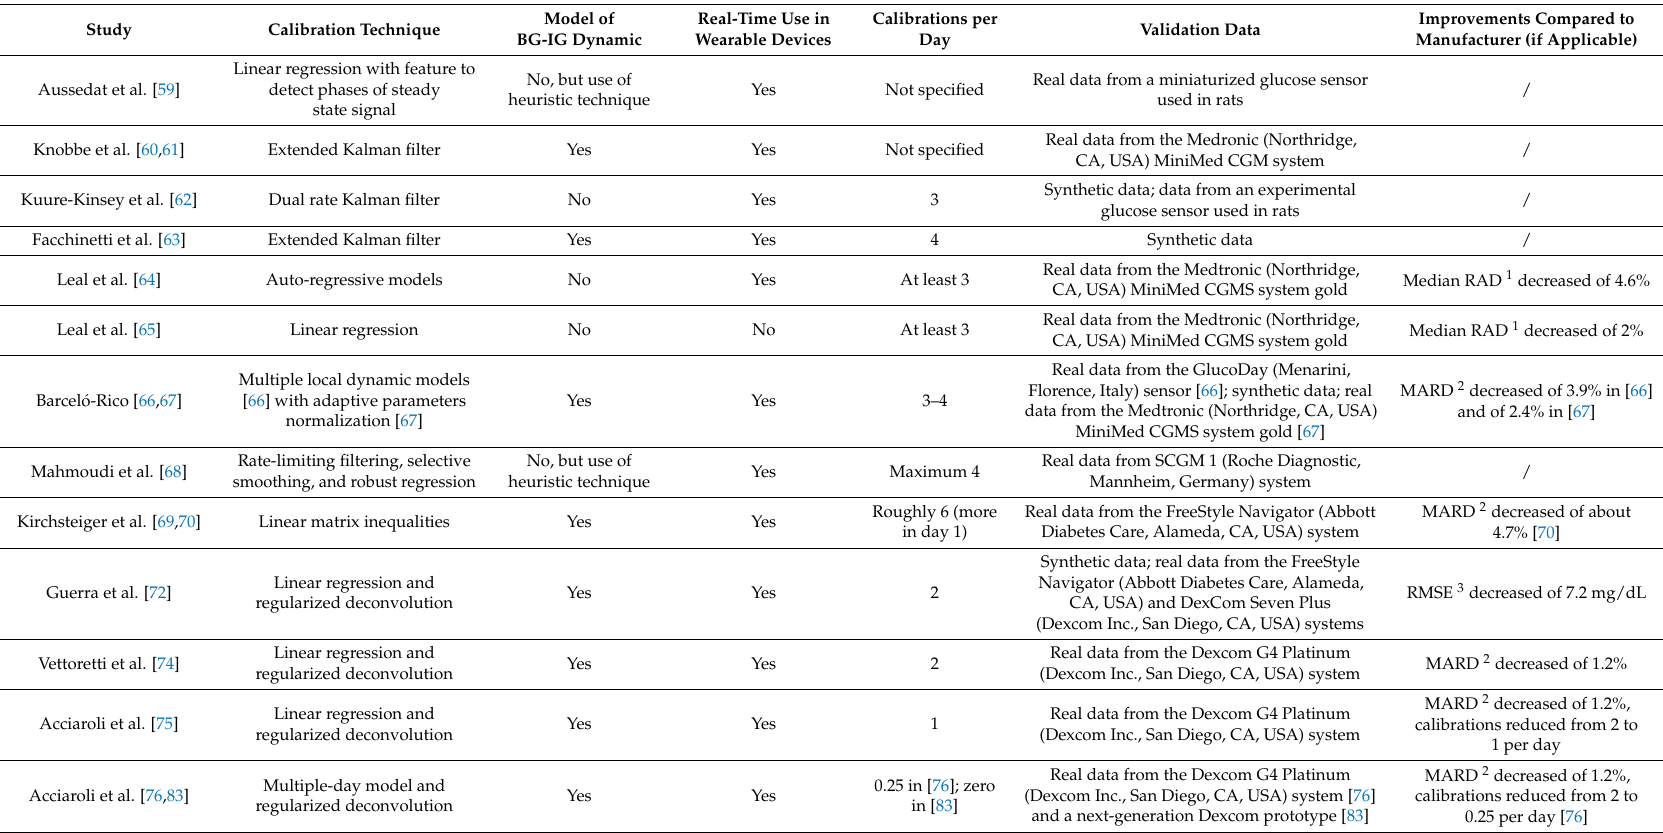
Table 1. Summary of the reviewed calibration